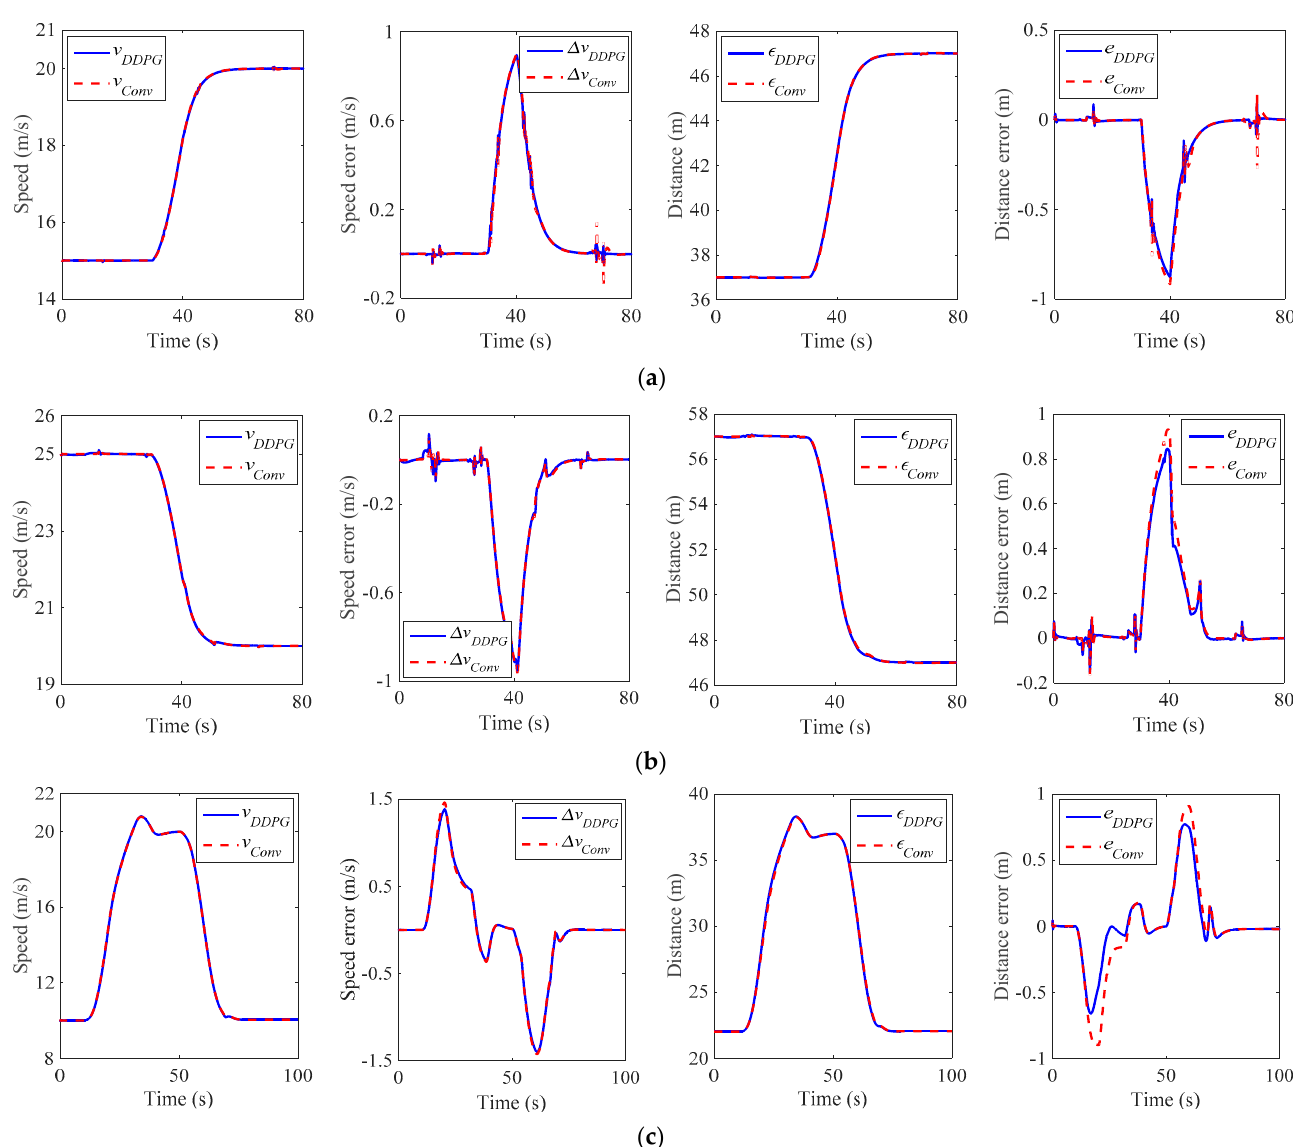
three experimental conditions are shown in Figure 12.